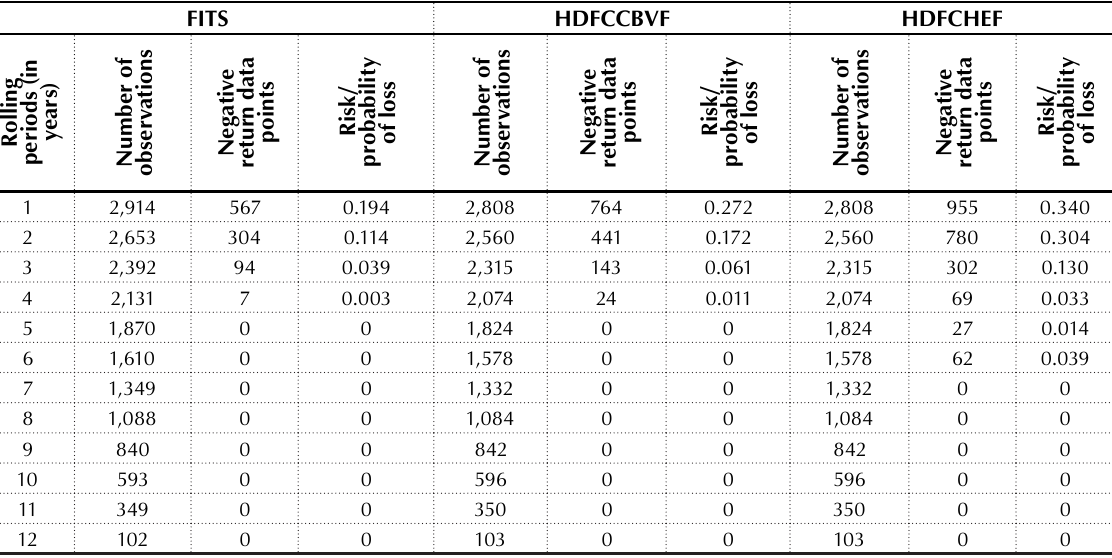
Table 17. Rolling period risk and return behavior of FITS, HDFCCBVF and HDFCHEF (2006-2018)